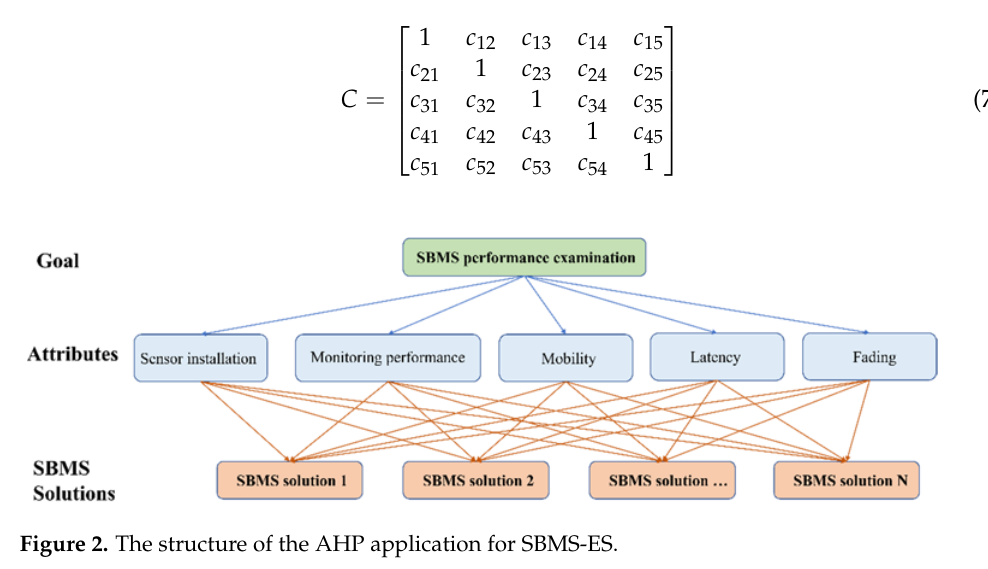
Figure 2. The structure of the AHP application for SBMS-ES.